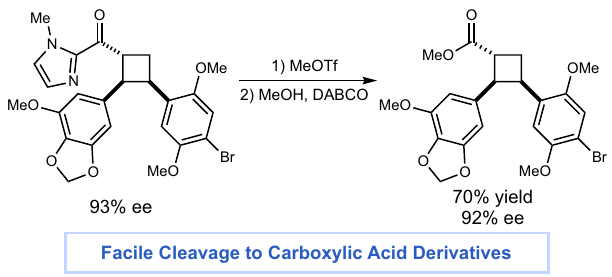
Fig. 4 Auxiliary cleavage. The imidazolyl group of the cycloadduct is readily cleaved in good yield with retention of enantioselectivity.